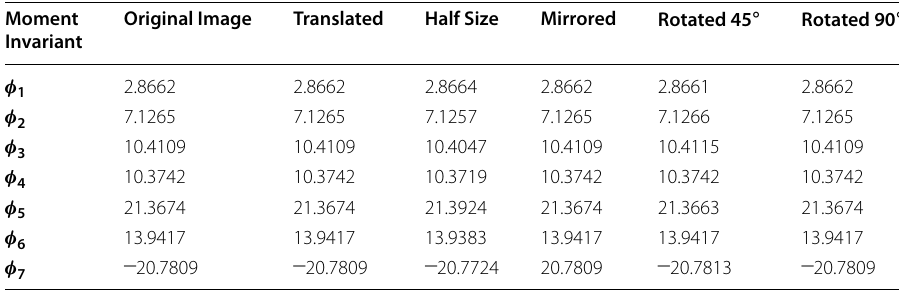
Table 1 Moment invariants of the images in Fig. 7 Moment Original Image Translated Half Size Mirrored Rotated 45 ◦ Rotated 90 ◦ Invariant φ 1